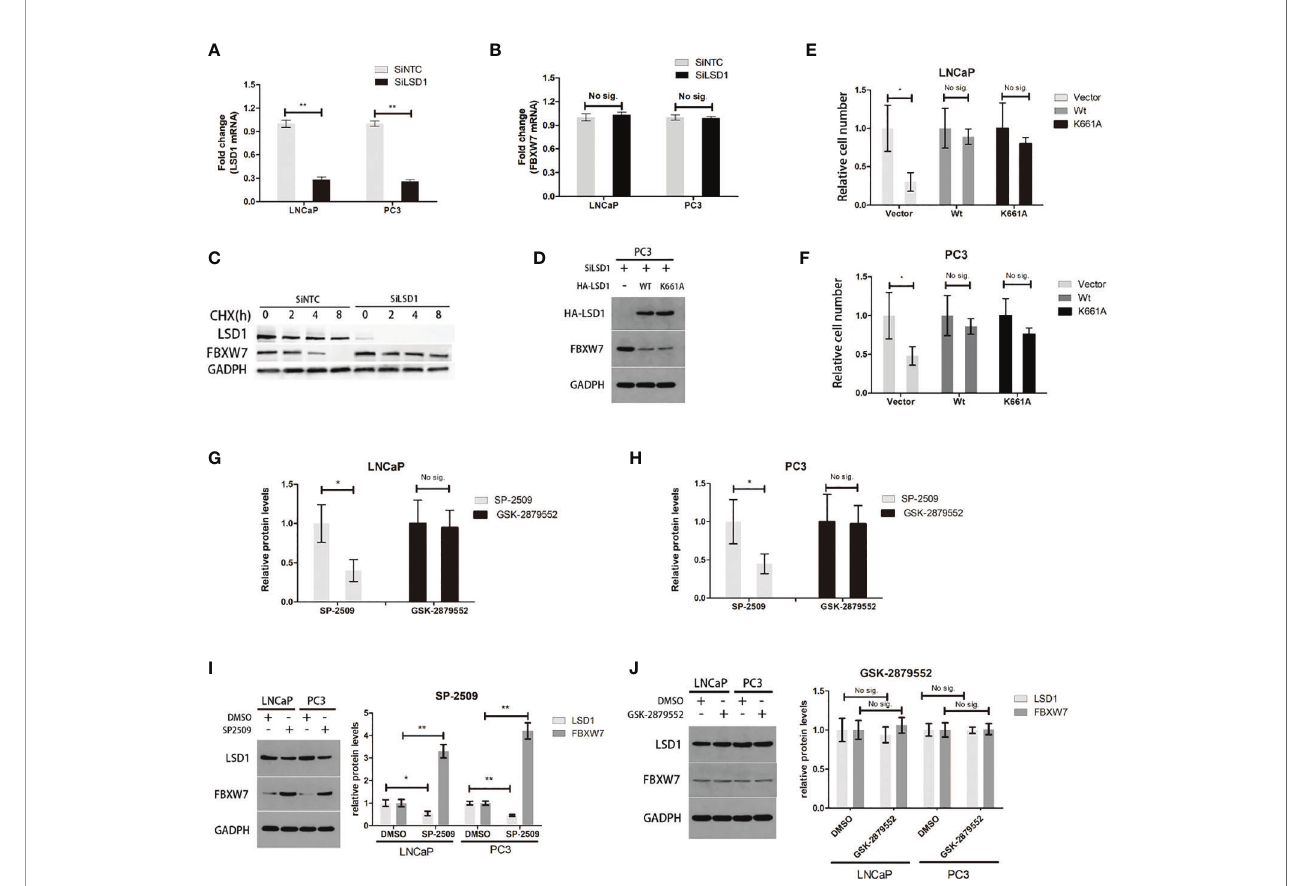
FIGURE 4 | It is independent of demethylation-function that LSD1 can destabilize FBXW7 in PCa. (A, B) The change of LSD1 and FBXW7 mRNA levels were detected by qPCR after LSD1 knockdown. (C) LSD1 and FBXXW7 half-life were detected by western blotting analysis at various time points, such as 0, 2, 4, and 8h after treatment of CHX. (D) Western blot analysis was used to detect protein expression level of LSD1 and FBXW7 in PC3 cells that were transfected with indicated exogenous protein. (E, F) Relative cell number of LNCaP and PC3 cells after transfected with exogenous wild-type LSD1 or catalytically de fi cient mutant K661A. Wild-type and catalytically de fi cient mutant LSD1 both can decrease FBXW7 protein level after transfected with SiLSD1 in PC3 cells. (G, H) Relative cell number of both cell lines after treated with SP-2509 or GSK-2879552 for 72h. (I, J) The relative protein expression level of LSD1 and FBXW7 in both cell lines after the treatment of inhibitors. The simple catalytic inhibitor GSK-2879552 cause no signi fi cant change. And SP-2509 cause the LSD1 depletion which results in up- regulation of FBXW7 expression level. This result is absent in GSK-2879552 treated group. Values are expressed as the mean ± SEM.*P < 0.05, **P<0.01, relative to the vector or DMSO group, n = 3. Protein levels were normalized by